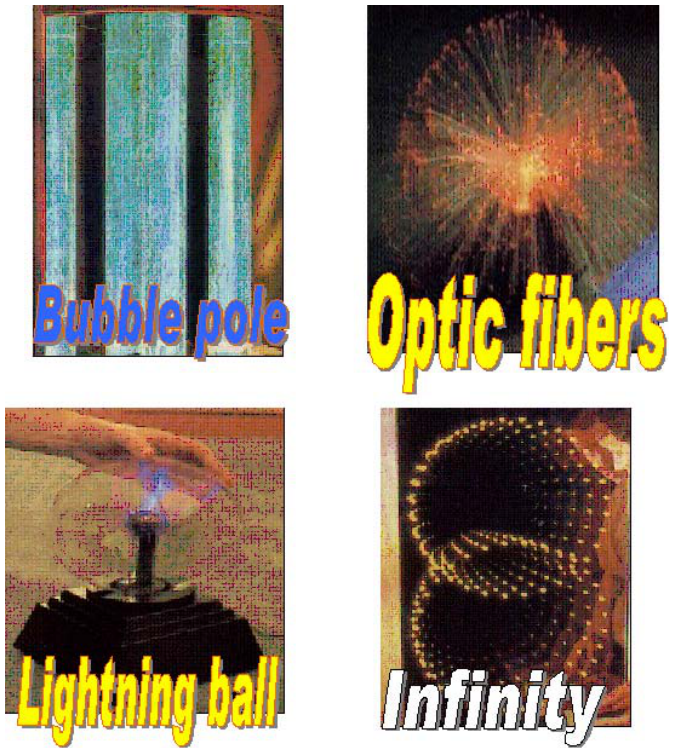
PICTURE 4 . Enhancing communication through choice-making cards in the Snoezelen environment.